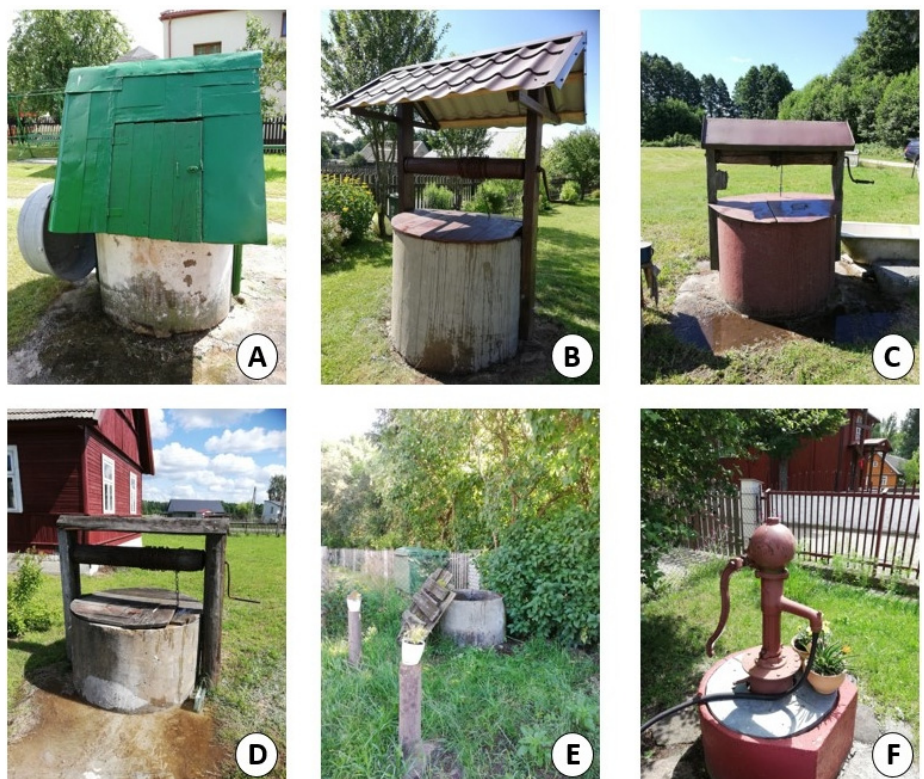
Figure 2. An example of the studied wells. A —Karakule; B and C — Ż uki; D —Zagruszany; E —Olmonty; F —Topolany.